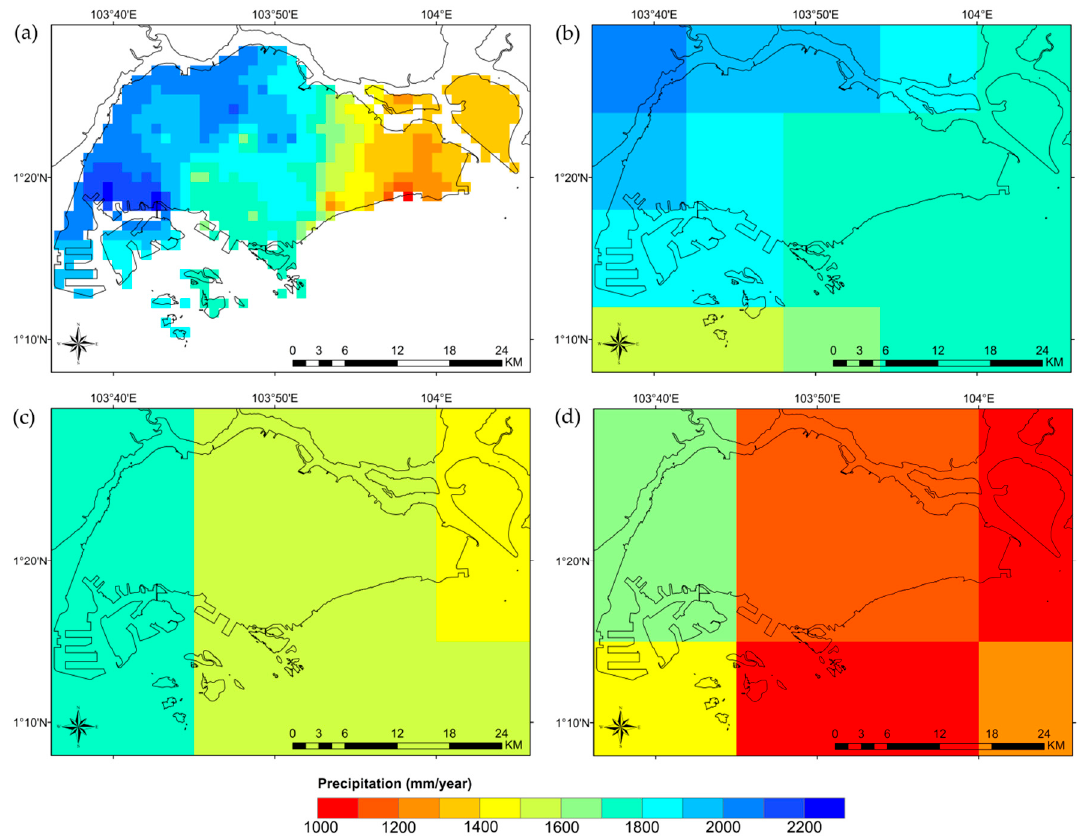
Figure 3. Spatial variability of the 2015 total annual precipitation interpolated of measurements from